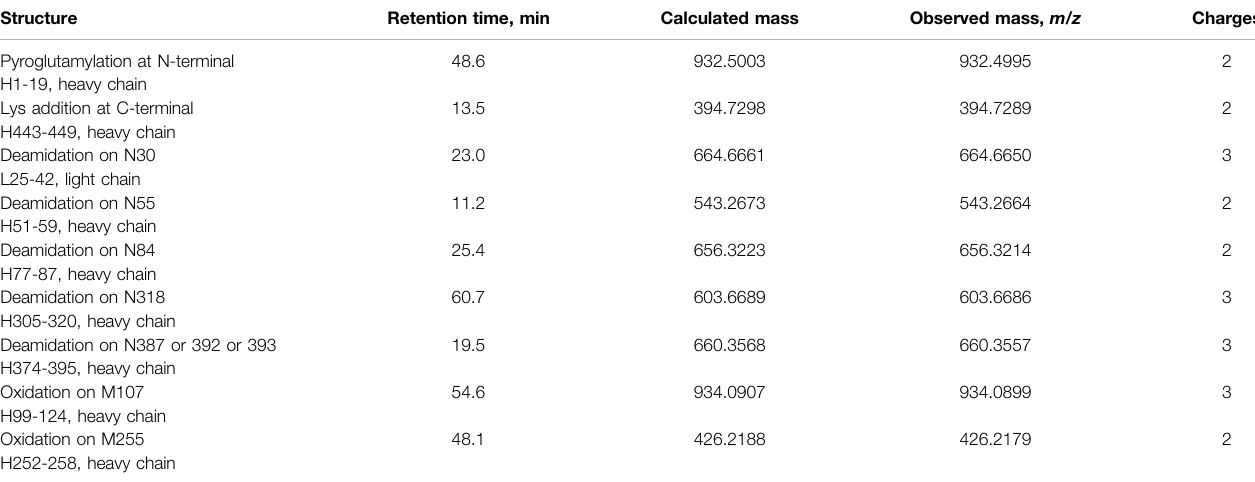
TABLE 1 | Summary of peptide mapping for modi fi ed structure including N and C terminal, deamidation, and oxidation via trypsin digestion. Calculated and observed masses represent monoisotopic masses. Structure Retention time, min Calculated mass Observed mass, m/z